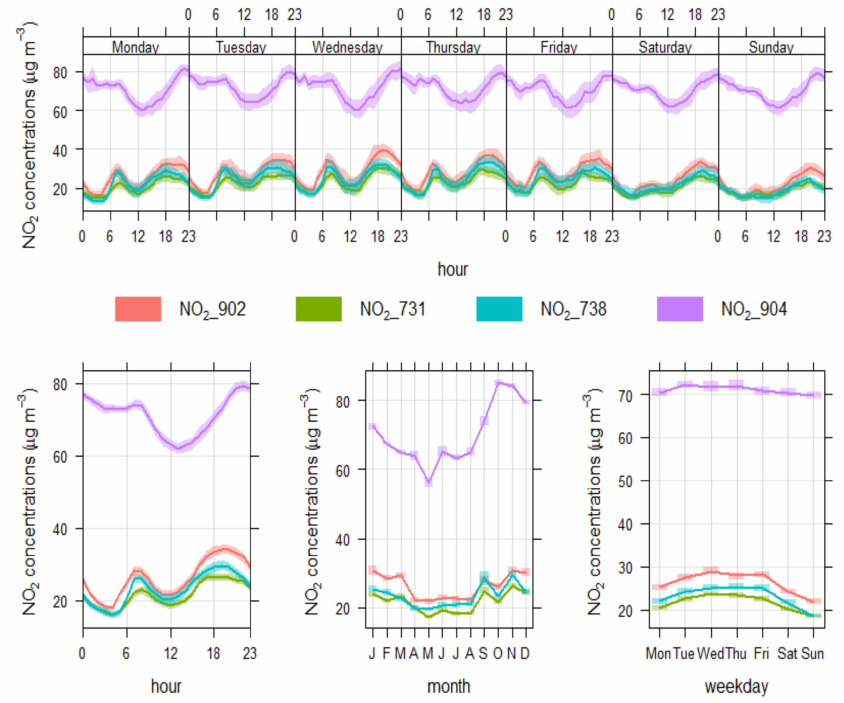
Figure 11. Time variation plots of NO 2 concentrations ( µ g/m 3 ) measured by Envirowatch E-MOTEs.